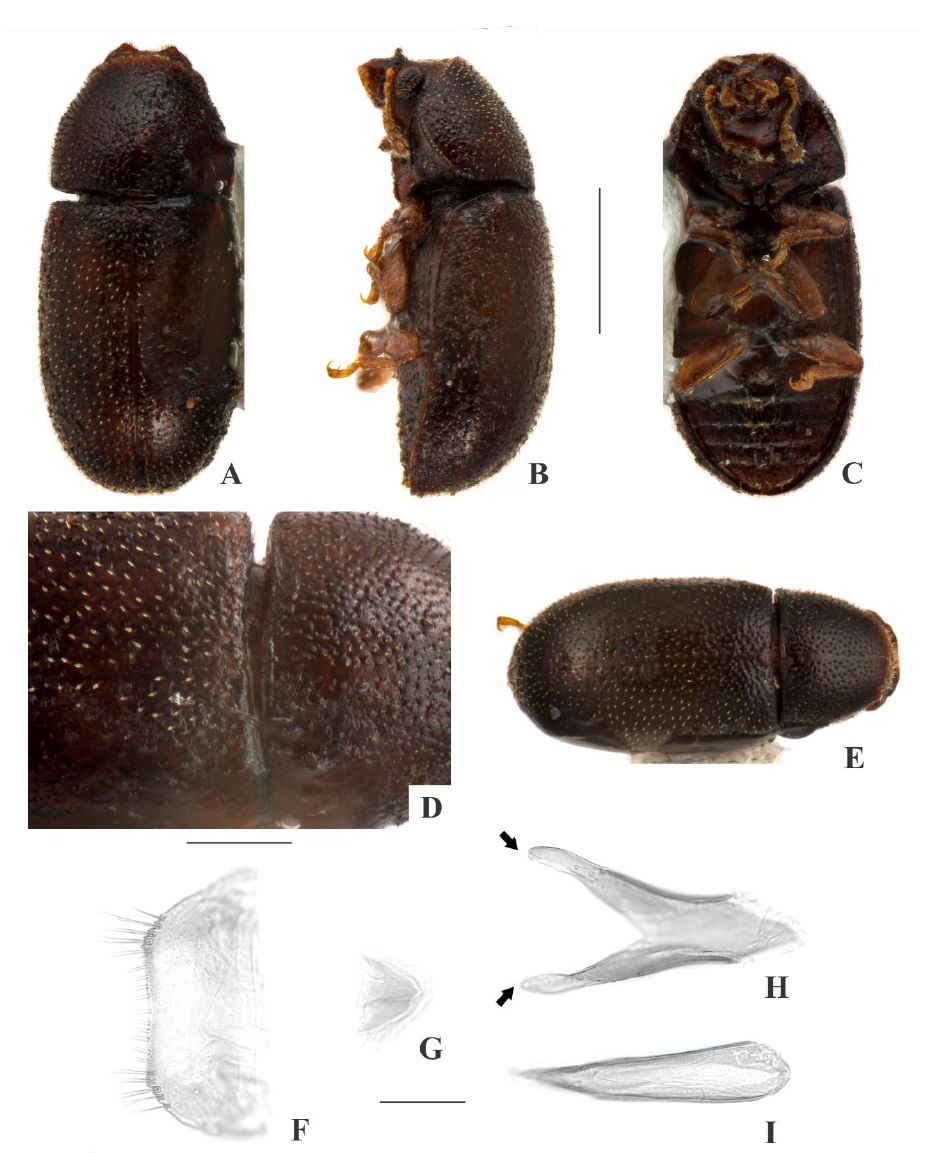
Figure 7. Cis mpumalangaensis sp. n. , male holotype ( A – D ), female paratype ( E ), aedeagus of paratype from type locality ( F – I ): ( A ) Dorsal view. ( B ) Lateral view. ( C ) Ventral view. ( D ) Scutellar shield and part of the pronotum and elytra. ( F ) Sternite VIII. ( G ) Basal piece. ( H ) Tegmen, note deep V-shaped emargination forming curved slender lateral struts at apex (black arrows). ( I ) Penis. Scale bars: 0.5 mm ( A – C , E ), 0.2 mm ( D ), 0.05 mm ( F – I ). Type locality: “Mooihoek Farm” (near Wakkerstroom), coordinates 27°13’ S 30°32’ E (Pixley Ka Seme Local Municipality, Gert Sibande District, Mpumalanga Province).